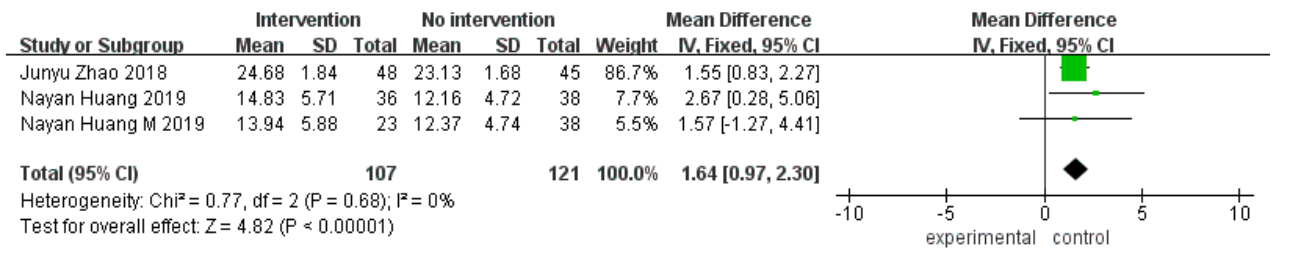
Figure 4. Forest plot of MoCA scale for overall cognitive function improvement [32,33].